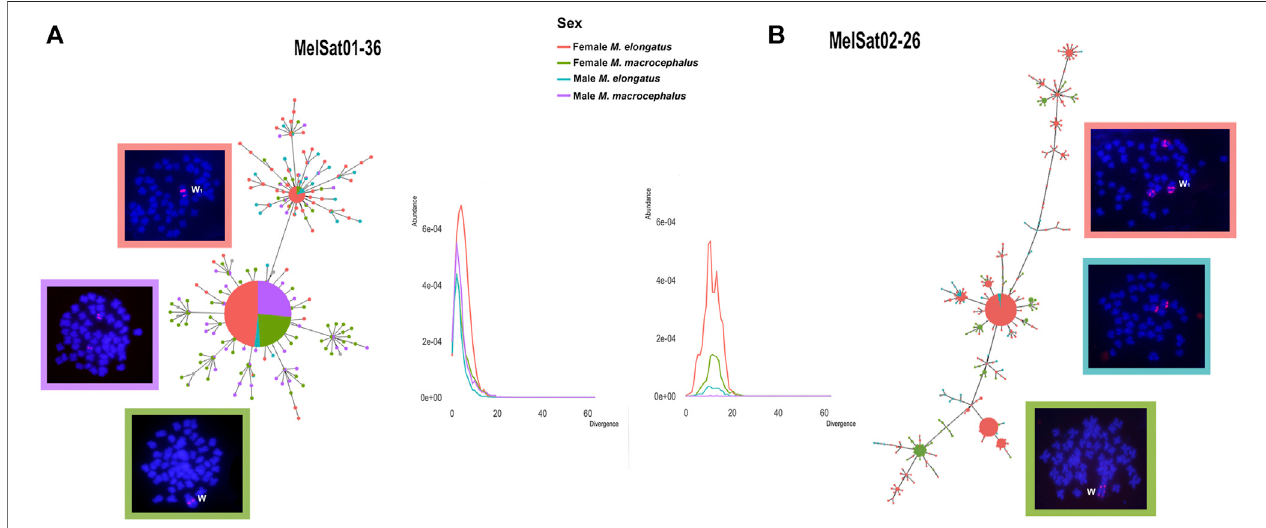
FIGURE 2 | MSTs showing the relationships between isolated monomers for MelSat01-36 (A) and MelSat02-26 (B) retrieved from M. elongatus and M. macrocephalus males and females. Respective FISH results and the heteromorphic sex chromosomes W and W 1 are indicated. Male FISH results for M. elongatus and M. macrocephalus are absent for MelSat01-36 and MelSat02-26 as no FISH signals were obtained, respectively. Abundance x divergence landscapes that shows the respective similar origins in both species are also indicated, but the substantial abundance in M. elongatus female for both satDNAs is apparent. Note the different divergences between the satDNAs, as MelSat02-26 has larger divergence values than MelSat01-36 and a rather dispersed organization in comparison to the